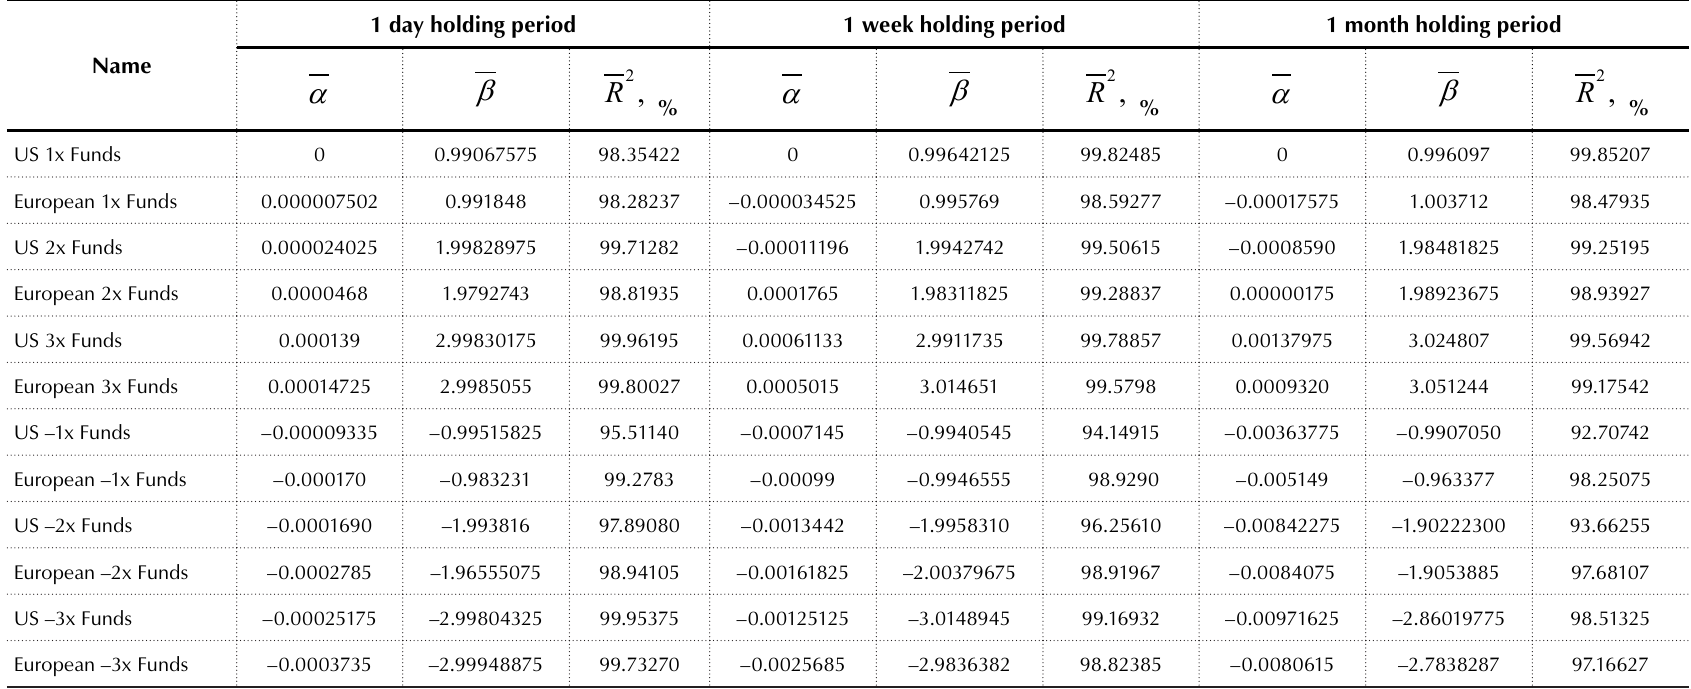
Table 5. US vs EU funds’ average regression coefficients during different holding